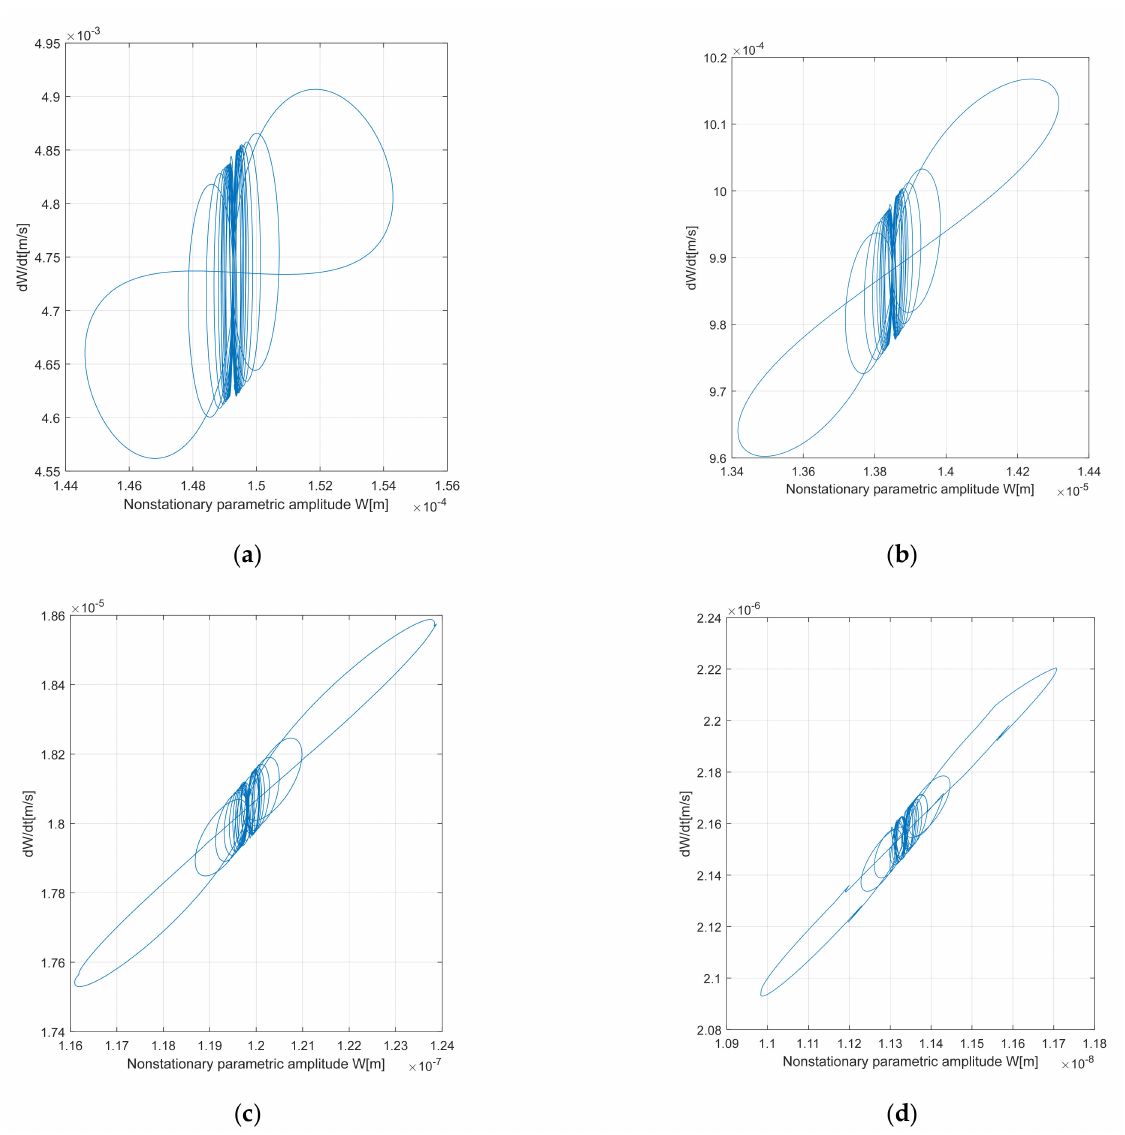
(cid:16) (cid:17) Figure 26. Phase space W, dW of the bowl for χ nB = 0.10, where µ = 0.754 × 10 − 4 . ( a ) ζ = 0.0016. dt ( b ) ζ = 0.0036. ( c ) ζ = 0.0076. ( d ) ζ = 0.0096. Here, m = 1.4 × 10 − 5